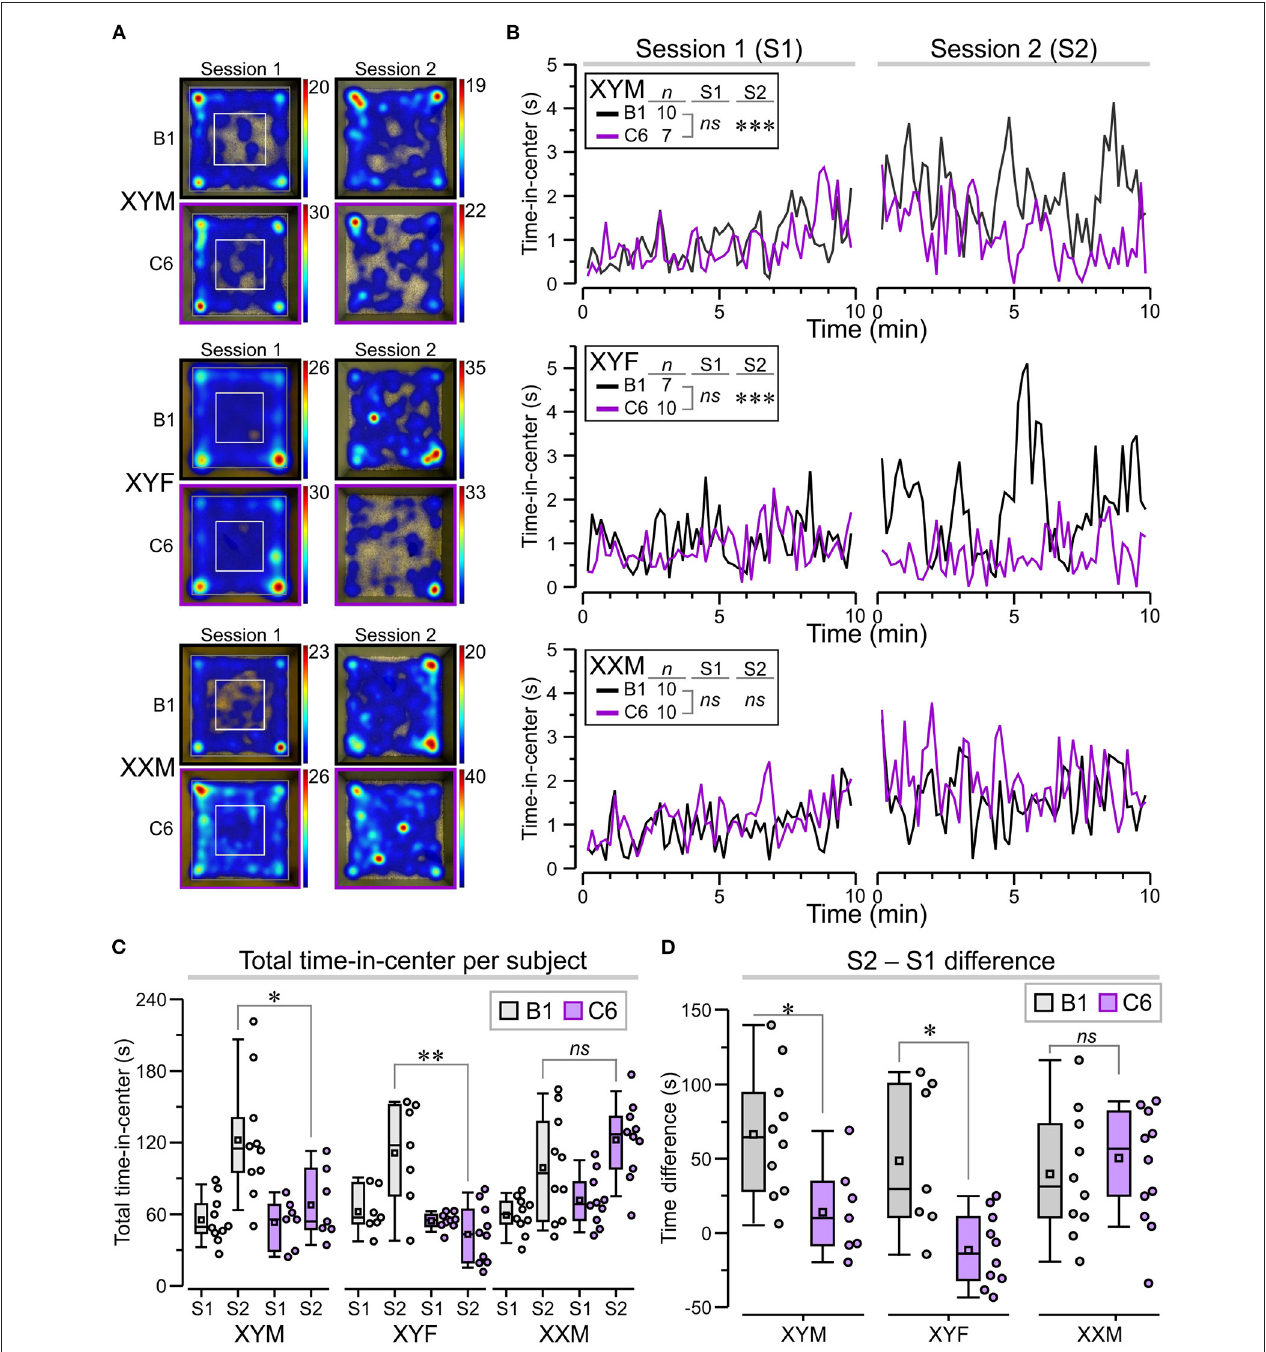
FIGURE 3 | Sustained anxiety-like behavior in C6-exposed XYM and XYF mice during the open-field task. (A) Top-view heatmaps of the open-field task for representative XYM, XYF, and XXM mice that were exposed in utero to anti-Caspr2 antibody (C6) or control antibody (B1). The color scale at the right of each heatmap represents seconds. (B) Graphs show the time spent at the center of the arena, taken over regular 10-s intervals during session 1 (S1) and session 2 (S2), for all groups. RMANOVA with Bonferroni post-hoc tests reveal significantly lower time-in-center, during S2, for C6-XYM mice compared to B1-XYM mice as well as C6-XYF mice compared to B1-XYF mice. (C) Box-and-whisker plots for time-in-center show mean (small square), median, Q1–Q3 quartiles (box), and 10–90 range (whiskers) for S1 and S2. Dots represent individual mice; 3-way ANOVA, followed by Tukey test, was used for statistical comparisons. (D) Difference for time-in-center between S2 and S1 show statistical differences for the XYM and XYF cohorts; 2-way ANOVA with Tukey test was used for statistical comparisons. See Table 1 and Supplementary Table 2 for details of statistical testing; ns = non-significant, * P < 0.05, ** P < 0.01, *** P < 0.001.